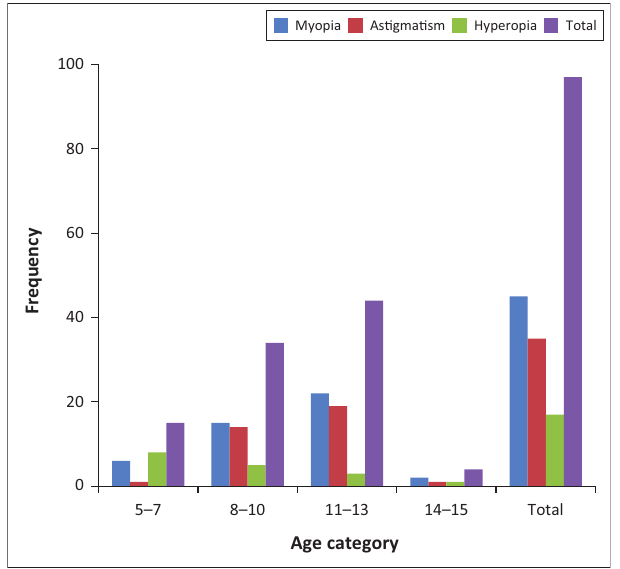
FIGURE 3: Distribution of refractive error by age group. TABLE 3: Distribution of types of astigmatism. Eye With-the-rule